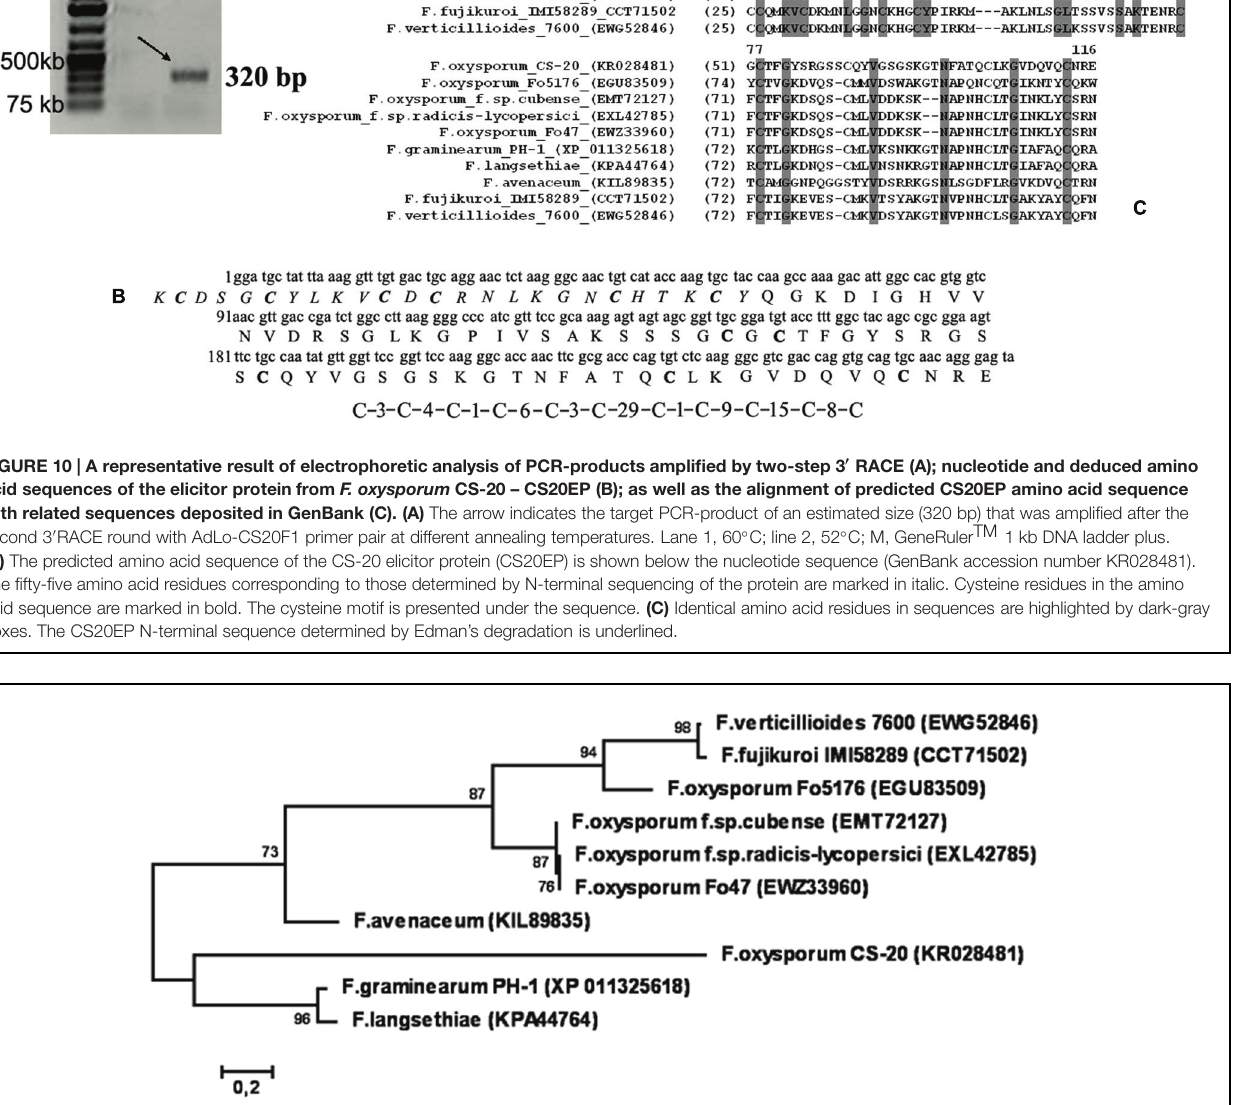
HYTLO1 was predicted to be 7.2 kDa cysteine-rich protein with eight cysteine residues arranged in a strictly conserved motif (Ruocco et al.,